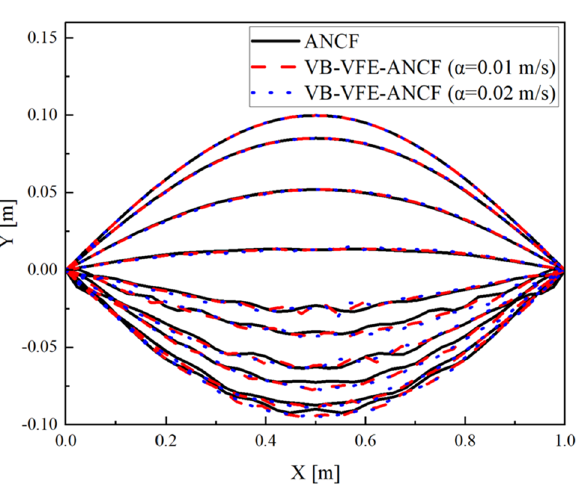
Figure 9. Comparison of Y coordinate values of flexible beam obtained using ANCF and VB-VFE-ANCF (left), and enlarged view (right). These results show that VB-VFE-ANCF is effective for the very flexible beam model with large deformation.